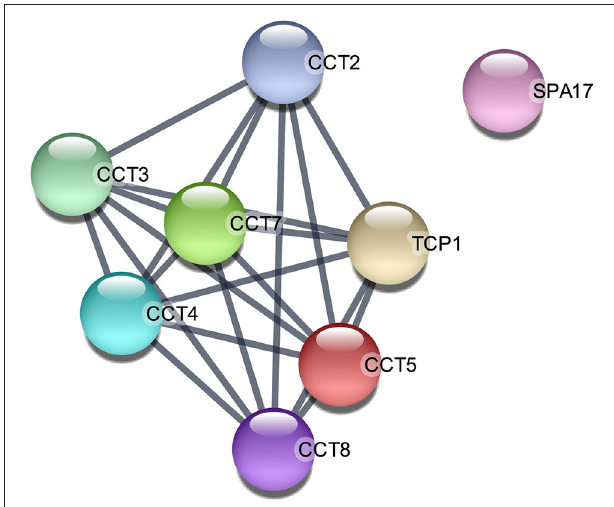
FIGURE 4 | Protein–protein interaction network among the upregulated proteins in post-ovulatory oviductal fluid belonging to the category single fertilization (GO:0007338). Lines between nodes indicate edges (representing protein–protein associations) with the highest confidence (0.900). The image was created with the STRING app for Cytoscape. CCT2 / CCT3 / CCT5 / CCT7 / CCT8 , chaperonin-containing TCP1 subunits 2, 3, 5, 7, and 8, respectively; SPA17 , sperm autoantigenic protein 17; TCP1 , T-complex